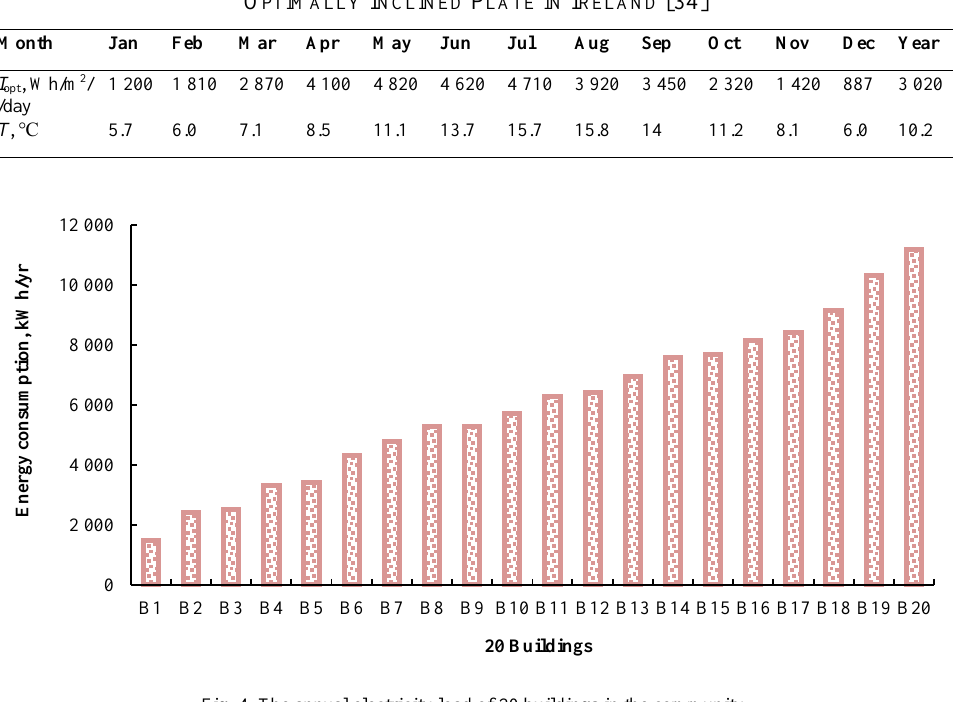
Fig. 4. The annual electricity load of 20 buildings in the